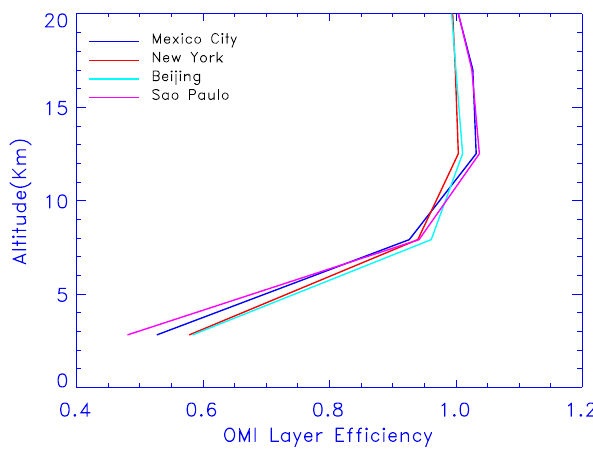
Fig. 4. Correlation between the TOR/TCO values and the corre- sponding NO 2 tropospheric columns from SCIAMACHY. All the data from the upstream and downstream transects from the 4 city examples shown in Fig. 1 have been plotted together.